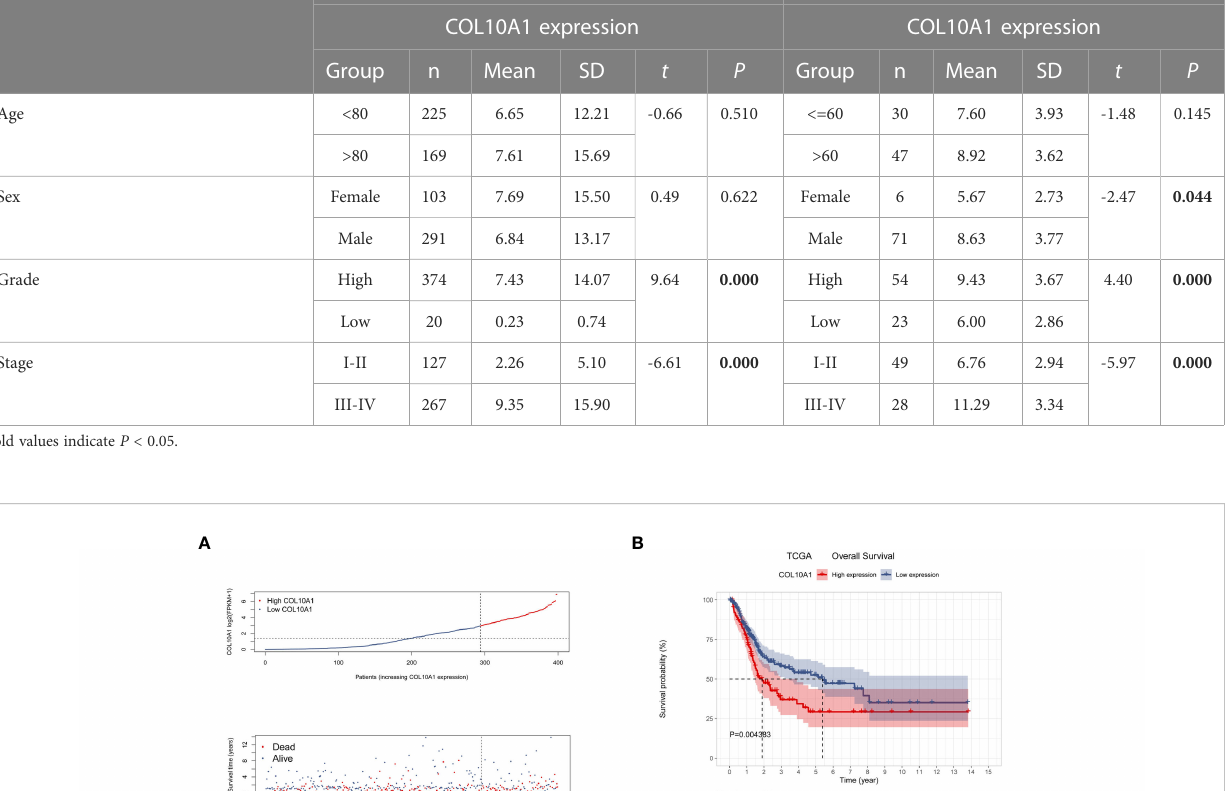
TABLE 1 Relationship between COL10A1 expression and clinicopathological parameters in BLCA.